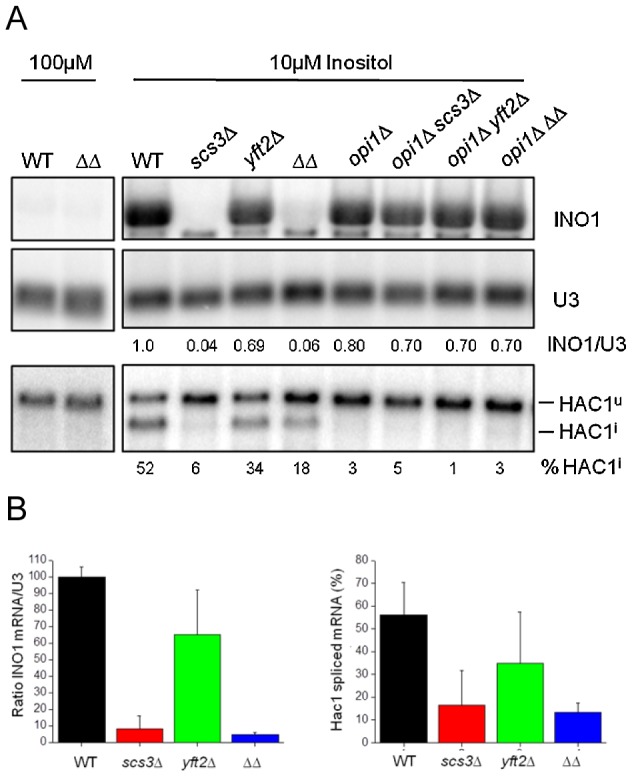

SCS3 and YFT2 gene-deletion strains are defective in the transcriptional response to low inositol.(A) Northern analysis of wild-type and gene-deletion strains grown in low inositol media. Cells were grown overnight to early log phase at 30°C in the presence of 10 µM inositol before RNA preparation. RNA from the same strains grown in 100 µM inositol is included for comparison. Detection and quantitation of INO1 and HAC1 mRNAs and U3 snRNA was as described in Figure 7c. The amount of INO1 mRNA normalized for U3 snRNA is expressed relative to the wild-type strain as indicated under each lane. The extent of Hac1 splicing is expressed as % of total HAC1 mRNA, normalized for U3 snRNA and is indicated under each lane. Note that deletion of OPI1 results in constitutive INO1 transcription and inositol prototrophy for the SCS3 and YFT2 deletion strains (see also Figure 9b), thereby alleviating the UPR response to low inositol (i.e. no Hac1 splicing in opi1Δ strains). (B) Data from three independent low inositol experiments, as shown above, are plotted ± standard deviation. The left panel shows the relative level of Ino1 mRNA and the right panel the extent of HAC1 mRNA splicing for each strain.